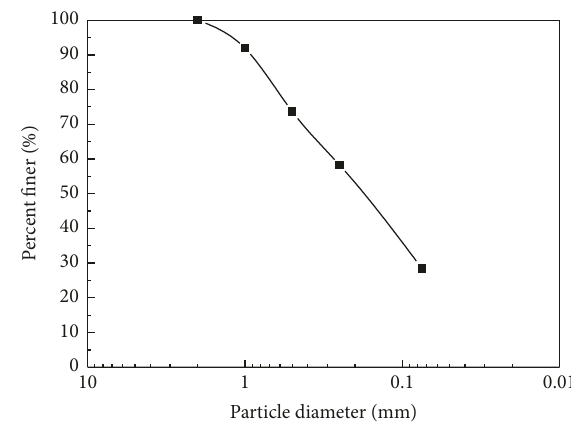
Figure 1: Grain size distribution curve of original expansive